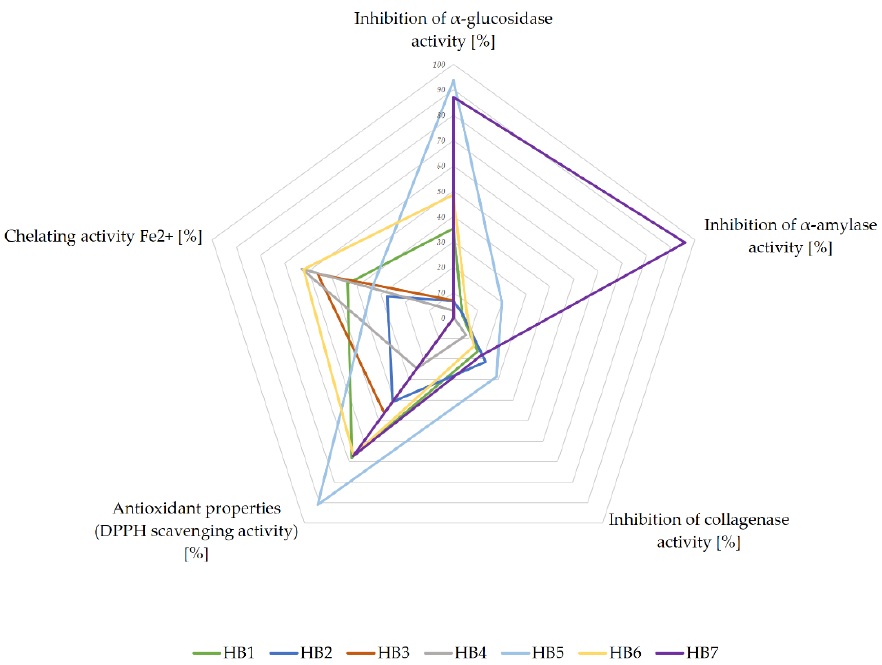
Figure 1. The antidiabetic potential of herbal blends 1–7 (HB 1–7), presented graphically, taking into account the measured biological properties expressed in %. The graph was made for the concentrations: inhibition of α -glucosidase activity 1.7 mg/mL; inhibition of α -amylase activity 26.7 mg/mL; inhibition of collagenase activity 2.4 mg/mL; antioxidant potential - DPPH assay 0.625 mg/mL; chelating activity 0.45 mg/mL.